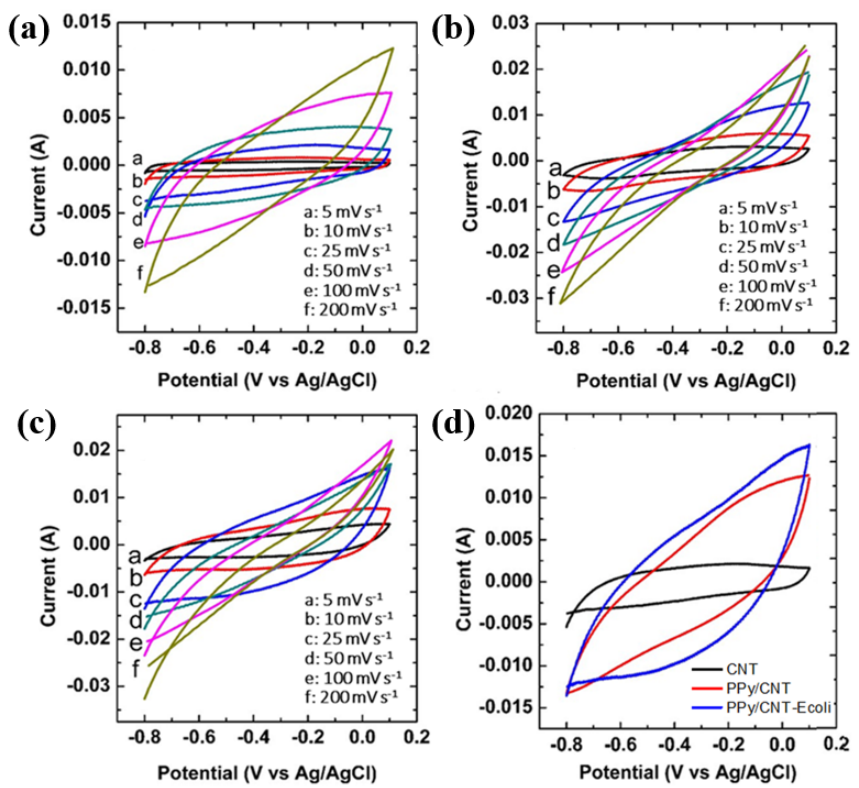
Figure 4. CV curves of ( a ) CNT, ( b ) PPy/CNT composite, ( c ) PPy/CNT –E. coli composite, and ( d ) CNT, PPy/CNT, PPy/CNT –E. coli at the scan rate of 25 mV · s –1 .